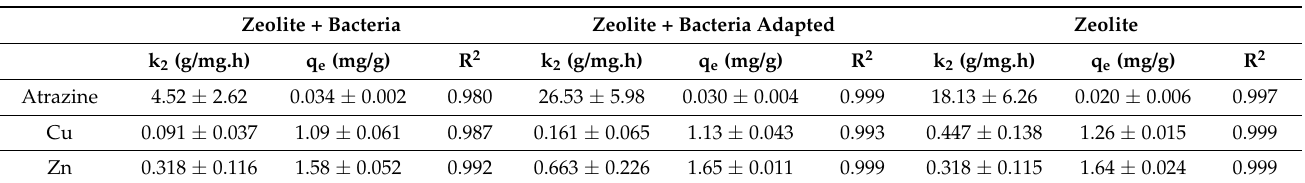
Table 3. Pseudo-second order model fittings for the biosorption/adsorption of atrazine, Cu and Zn for the different sorption systems in